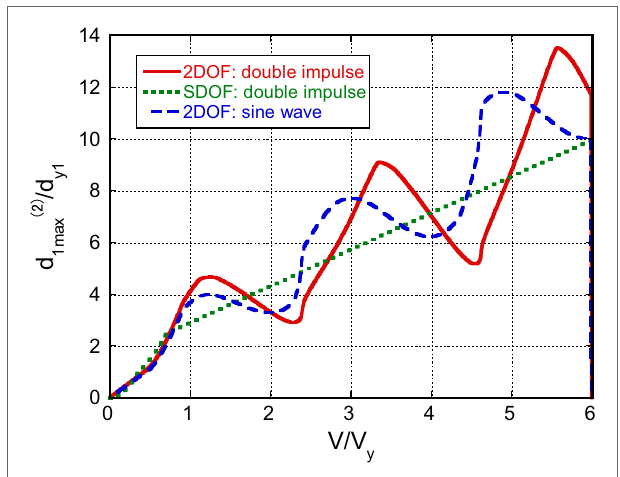
FigUre 11 | Maximum interstory drift after the second impulse in the first story.